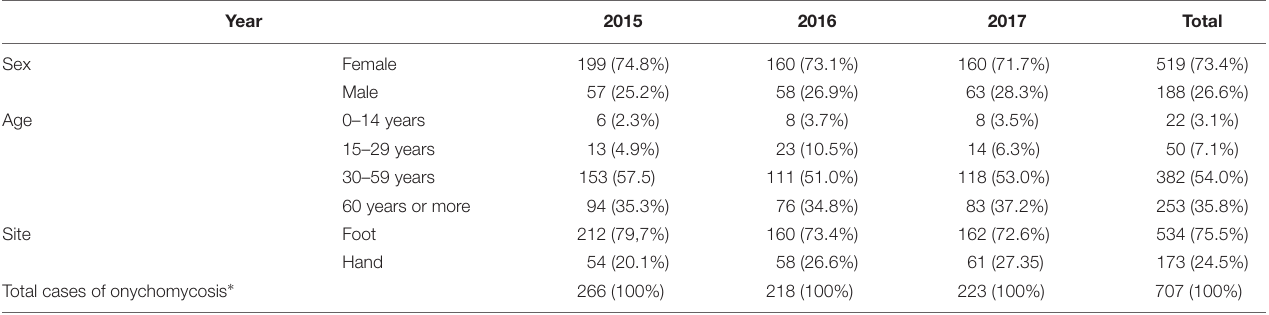
TABLE 3 | Demographic data for 707 patients seen at the Teaching and Research Laboratory of Clinical Analysis at the Universidade Estadual de Maringá from January 2015 through December 2017, with laboratory and clinically confirmed